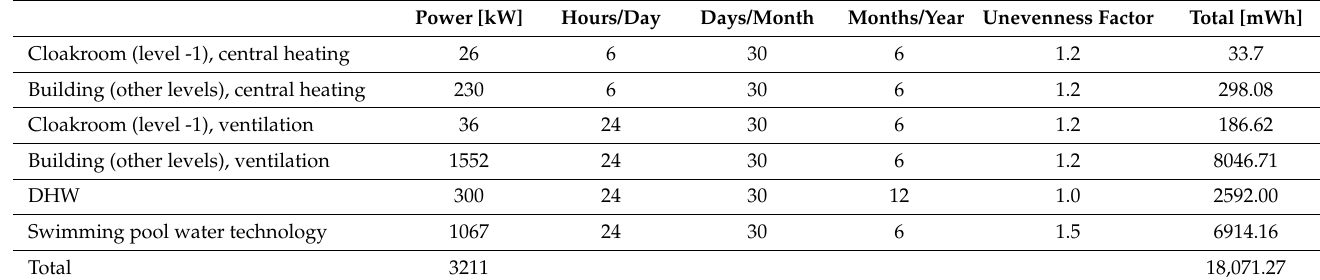
Table 8. Heat production, based on power demand for the new leisure and recreation